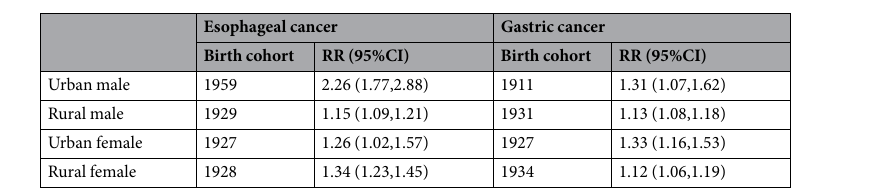
Table 2. Highest cohort effects (rate ratio, RR) on esophageal and gastric cancer mortality rates and the corresponding birth cohorts, compared with the 1939 birth